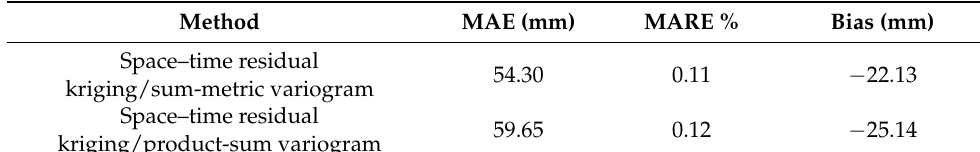
Table 1. Estimation error of the different methods applied with the available dataset to estimate the annual precipitation values for the hydrological year 2016/17. MAE stands for mean absolute error, MARE for mean absolute relative error, and bias is the difference between observations and estimations.